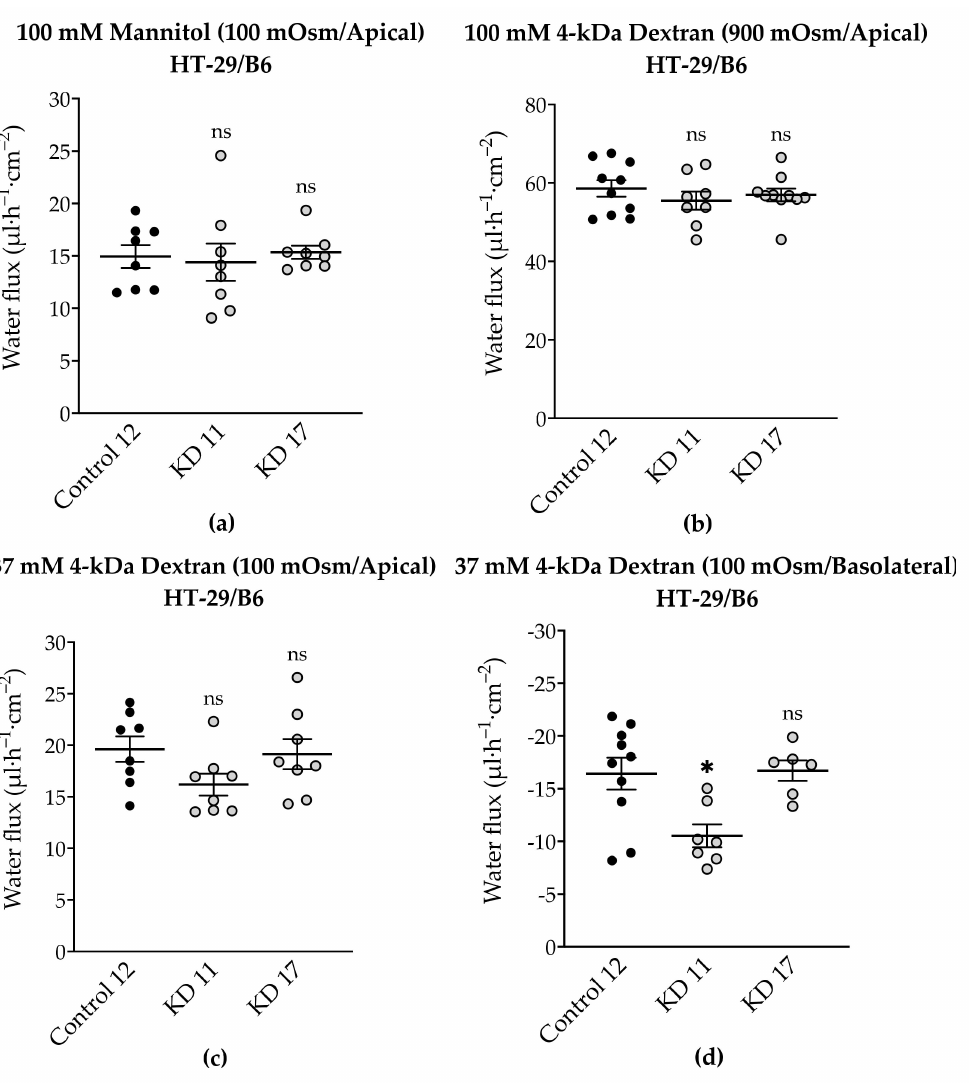
Figure 10. Water flux in control and tricellulin knockdown HT-29/B6 cells stimulated by an osmotic gradient. ( a ) Water flux induced by a gradient of 100 mM mannitol on the apical side. ( b ) Water flux induced by a gradient of 100 mM 4-kDa dextran on the apical side. ( c ) Water flux induced by a gradient of 37 mM 4-kDa dextran gradient on the apical side. ( d ) Water flux induced by a gradient of 37 mM 4-kDa dextran gradient on the basolateral side of the cell layer. ( n = 8–10, ns: not significant, * p ≤